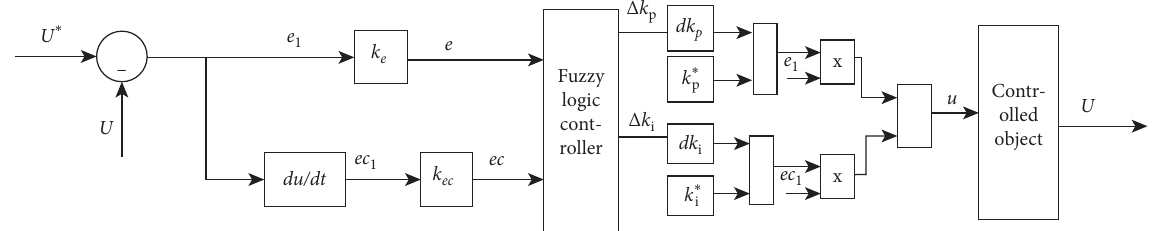
Figure 3: Fuzzy double closed-loop control structure diagram.